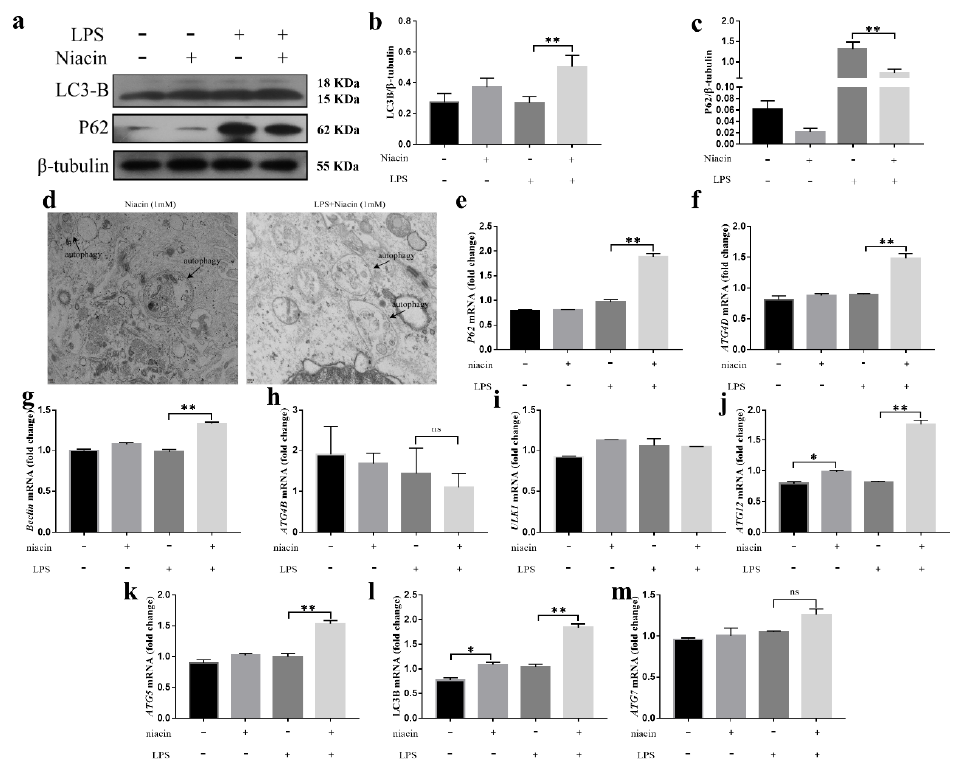
Figure 5. GPR109A alleviates inflammation of BMECs by regulating autophagy. Cells from different experimental groups were treated with niacin, LPS, or niacin + LPS for 24 h, and then, the total protein was collected. The cell lysates were prepared and subjected to Western blotting using β -tubulin ( a ), LC3B ( a , b ), and P62 ( a , c ) antibodies. Each immunoreactive band was digitized and expressed as